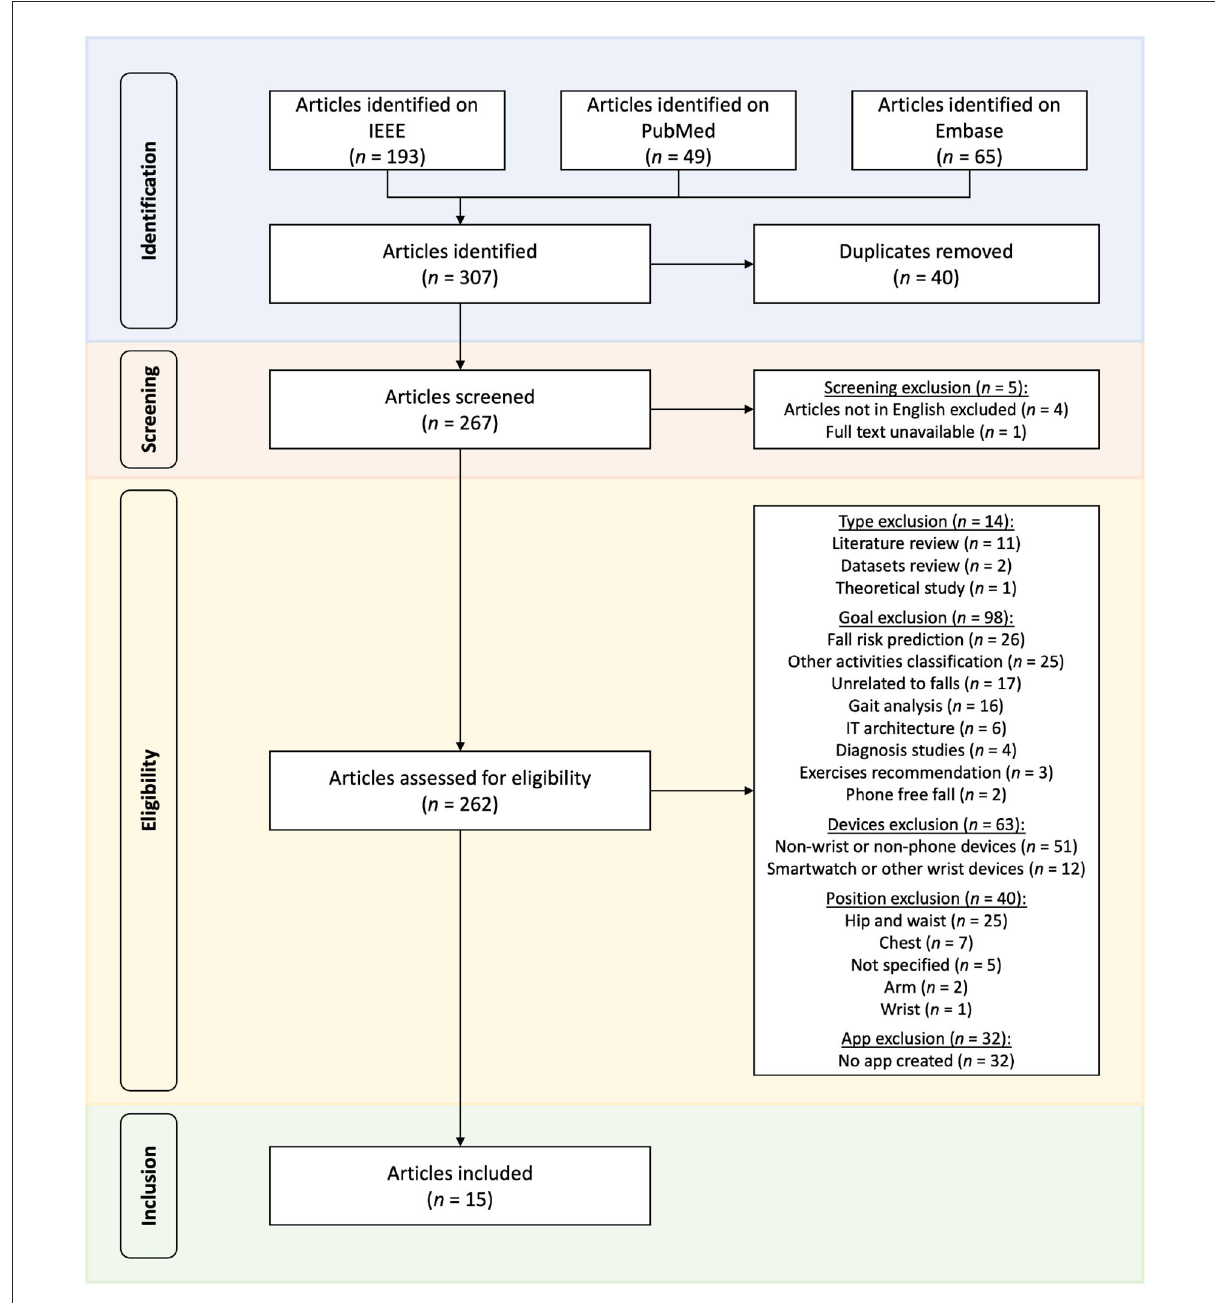
FIGURE2 PRISMA diagram of the selection of relevant articles for practical fall detection using smartphone